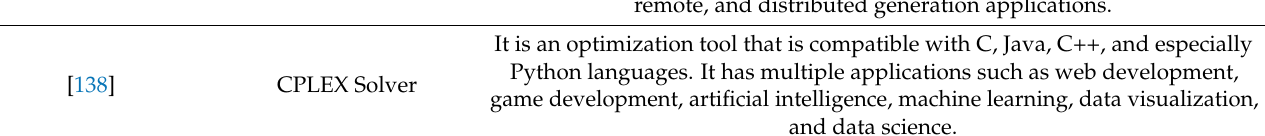
Table 5. Simulation software used in the energy management of campus microgrids.